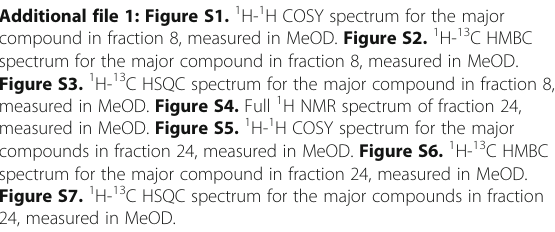
Additional file 1: Figure S1. 1 H- 1 H COSY spectrum for the major compound in fraction 8, measured in MeOD. Figure S2. 1 H- 13 C HMBC spectrum for the major compound in fraction 8, measured in MeOD. Figure S3. 1 H- 13 C HSQC spectrum for the major compound in fraction 8, measured in MeOD. Figure S4. Full 1 H NMR spectrum of fraction 24, measured in MeOD. Figure S5. 1 H- 1 H COSY spectrum for the major compounds in fraction 24, measured in MeOD. Figure S6. 1 H- 13 C HMBC spectrum for the major compound in fraction 24, measured in MeOD. Figure S7. 1 H- 13 C HSQC spectrum for the major compounds in fraction 24, measured in